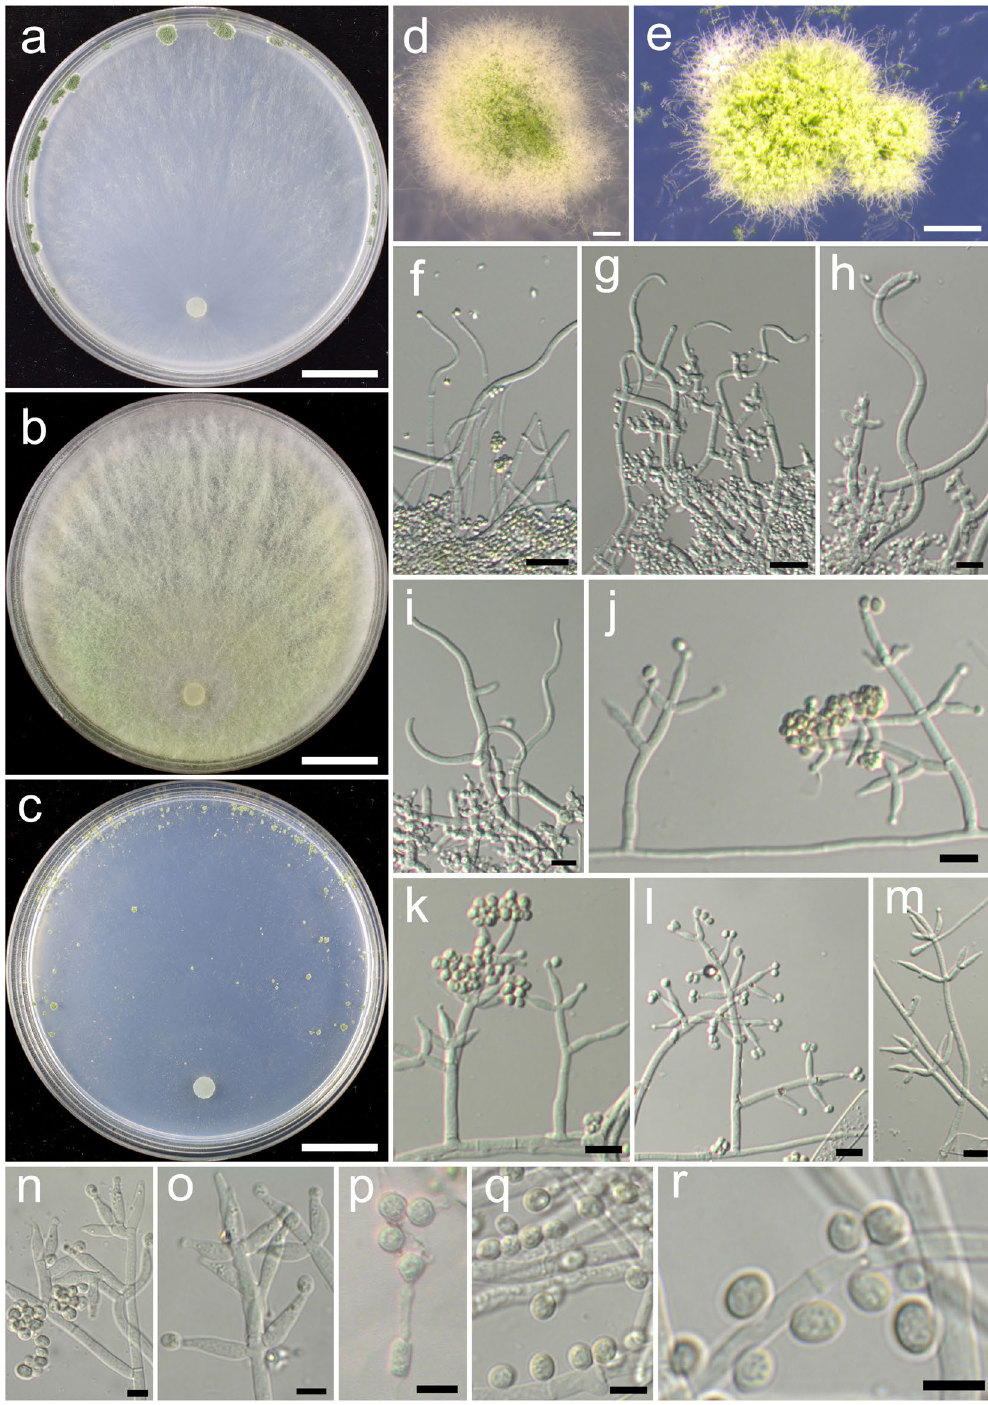
Figure 23. Trichoderma undatipile (HMAS 248854). ( a – c ) Cultures at 25 °C (a. on CMD, 10 d; b. on PDA, 7 d; c. on SNA, 10 d); ( d , e ) Conidial pustules (d. CMD, 7d; e. SNA, 7 d); ( f – i ) pachybasium-like conidiophores and phialides (CMD, 7 d); ( j – o ) Verticillium-like synanamorph (PDA, 4 d); ( p ) Chlamydospores (SNA, 7 d); ( q , r ) Conidia (PDA, 4 d). Bars: a–c = 20 mm. d–e = 200 μ m. f–g = 20 μ m. h–m, p = 10 μ m. n,o,q,r = 5 μ